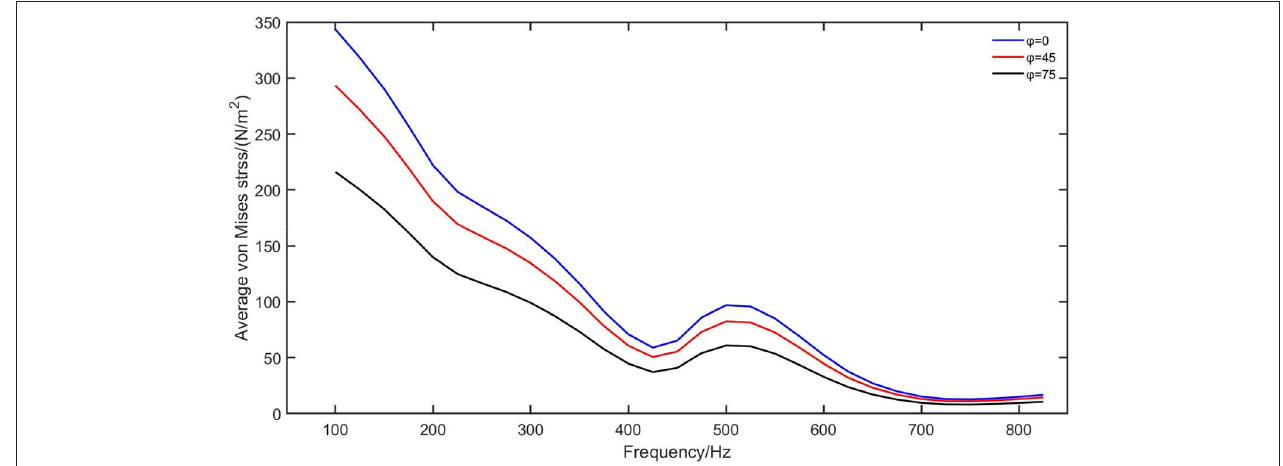
FIGURE 11 | Average von Mises stress of the whole structure under different incident angles at